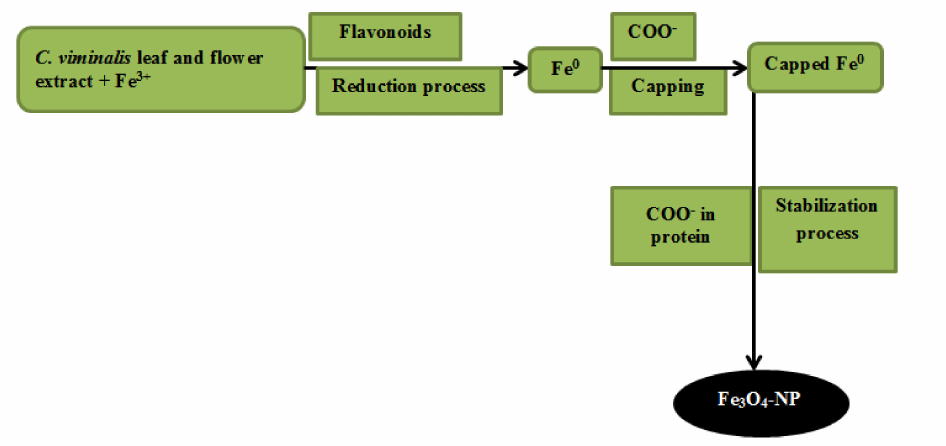
Figure 6. Possible absorption mechanism of bio-reduced Fe 3 O 4 -NP.